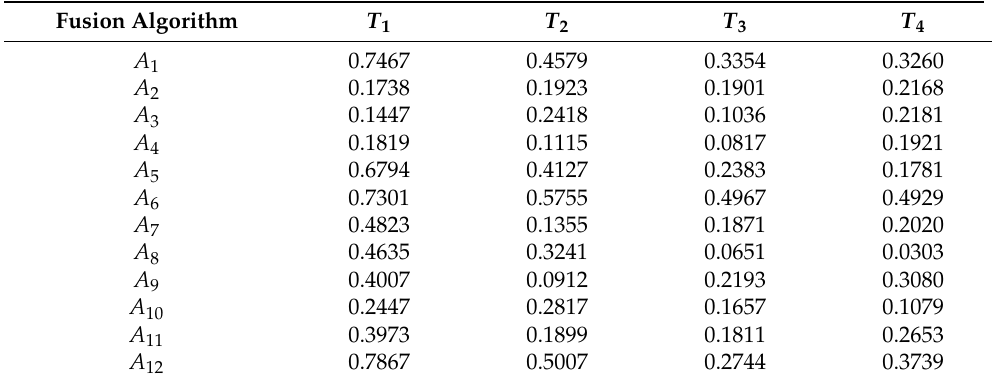
Table 4. The total evaluation values of difference